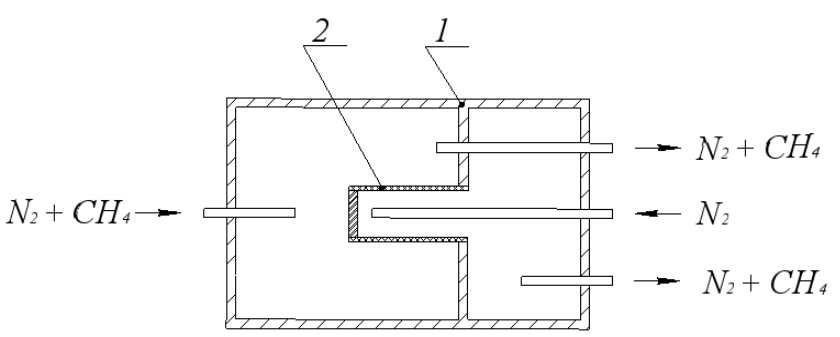
Figure 2. Diagram of a membrane reactor for determining the effective diffusion coefficient of methane in a mixture with nitrogen: 1—membrane reactor, 2—diaphragm (membrane catalyst).